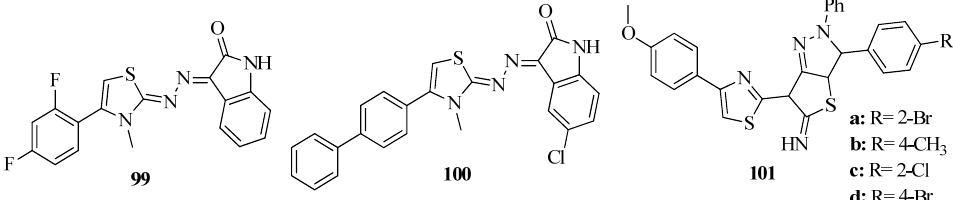
Figure 39. Structures of 3-3-{2-[2-3-methyl-4-phenyl-2,3-dihydro-1,3-thiazol-2-ylidene]hydrazin-1- ylidene-2,3-dihydro-1H-indol-2-one and pyrazolo[3.4,d]thiazole derivatives.